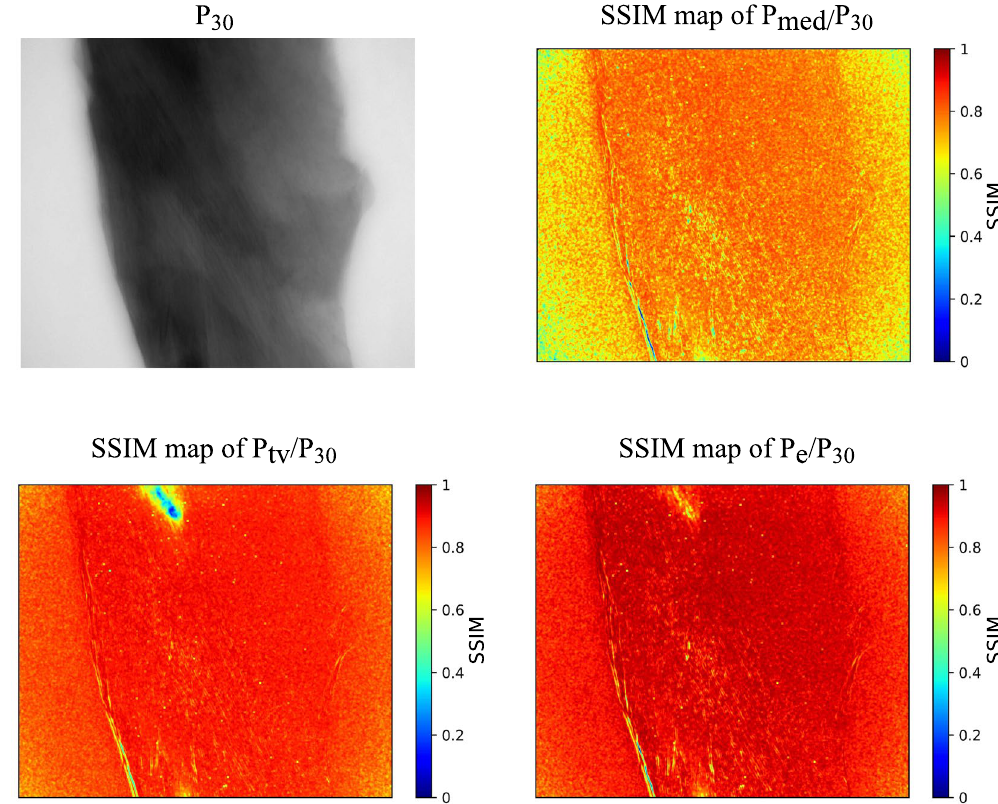
Figure 6. Comparing the CNN projection enhancement algorithm with the traditional denoising algorithms. The top left image is the projection with 30 s exposure time at 0°. The top right is the SSIM map between the 2 s projection denoised with median filter and the 30 s projection P med (0)/ P 30 (0). The bottom left is the SSIM map between the 2 s projection denoised with tv filter and the 30 s projection P tv (0)/ P 30 (0). The bottom right is the SSIM map between the CNN enhanced projection and the 30 s projection P e (0)/ P 30